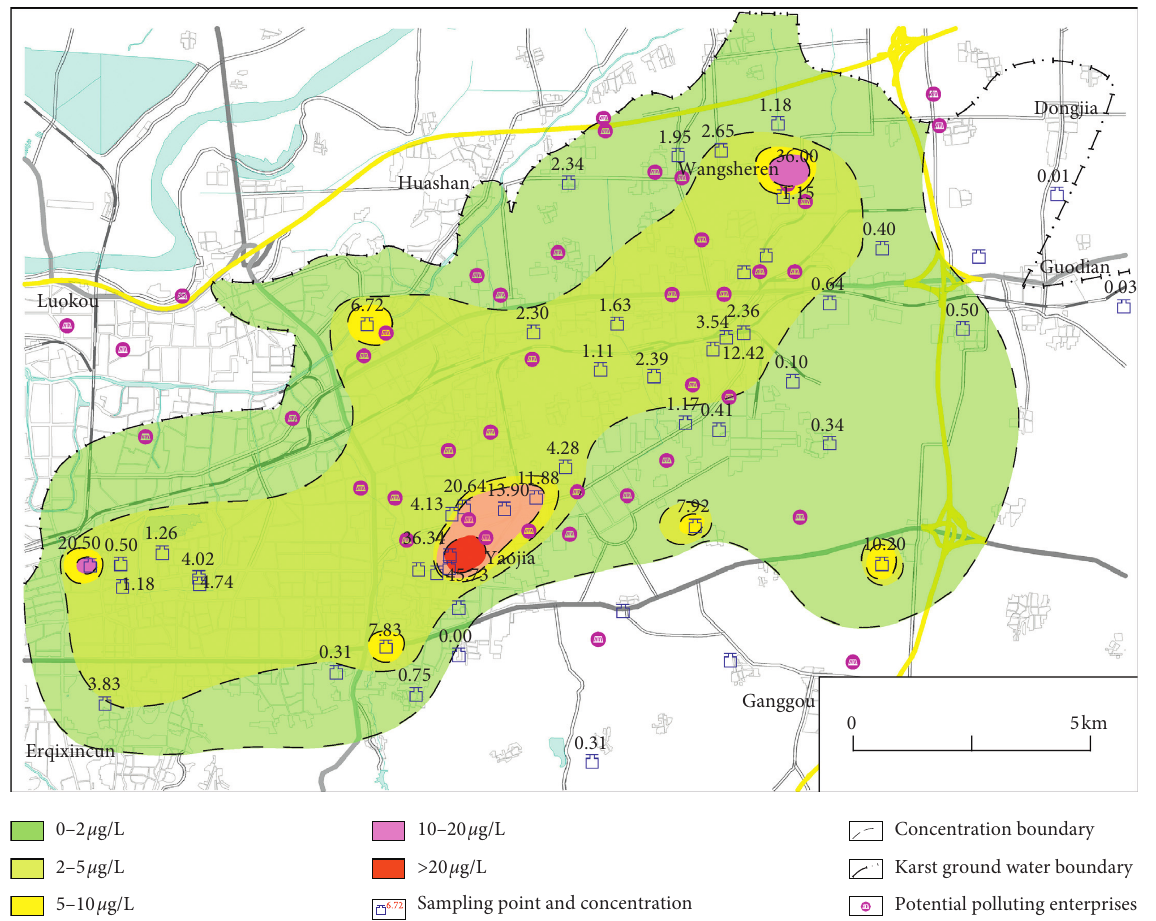
Figure 6: Distribution of total toxic organic compounds in fractured karst water in northeast spring